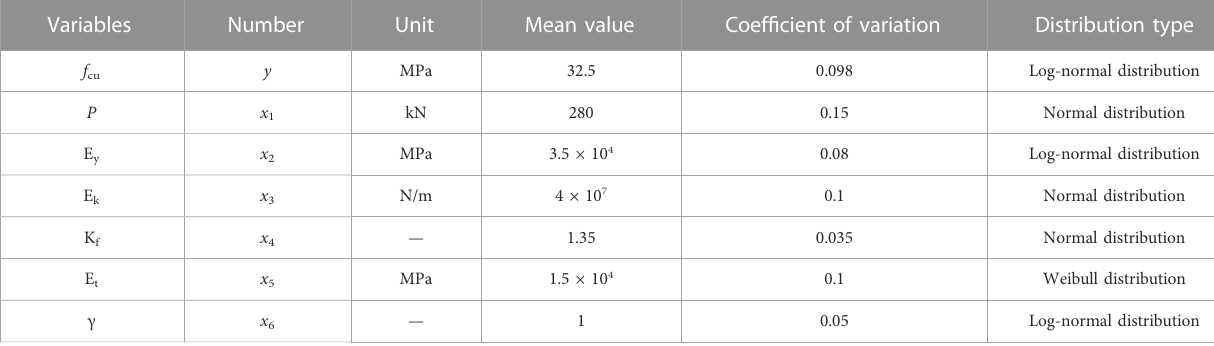
TABLE 3 General description of random